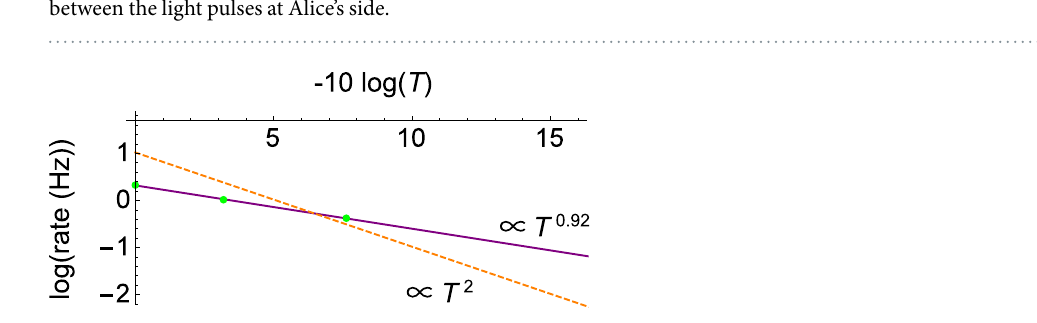
Figure 5. The observed count rate of the states protected by the DFS. The solid line fitted to the experimental data proportional to T 0.92 ± 0.02 . The broken line proportional to T 2 is expected when the 2-qubit DFS method with a forward-propagating reference single photon 12 is used. We assumed that the encoding and decoding are performed by using a conventional linear optics 12 . The line passes through a value μ − 1 /2 times as large as the observed rate for T = 1. We note that the standard deviations of all data with an assumption of the Poisson statistics of the counts are much smaller than the size of the green